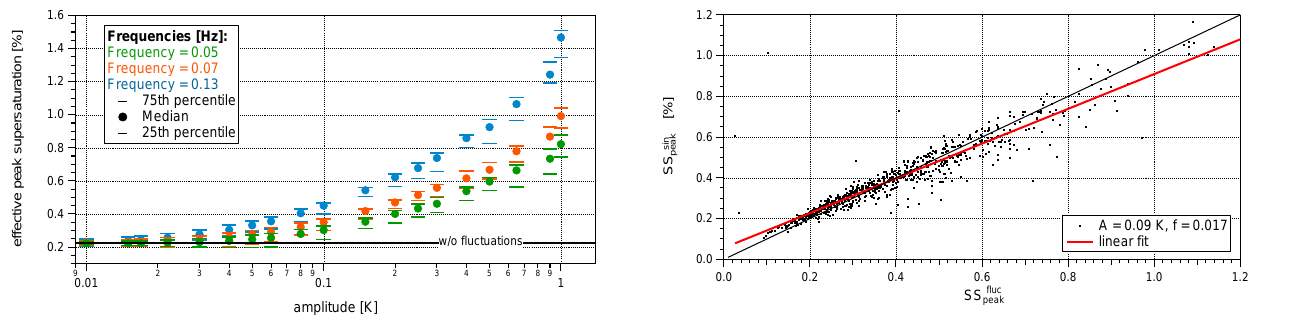
Figure 11. Dependency of the modelled effective peak supersatura- tions applying simulated small-scale fluctuations (SS fluc,sin cooling rate on the amplitude. The applied small-scale fluctuation were obtained with a sinus function using three different frequen- cies f = 0 . 05 (green), 0.07 (red) and 0.13Hz (blue), several ampli- tudes in the range from 0.01 to 1.5K and phases from 0 to 360 ◦ with 18 ◦ steps. The circles indicate the median values, while the bars show the 25th and 75th percentiles.